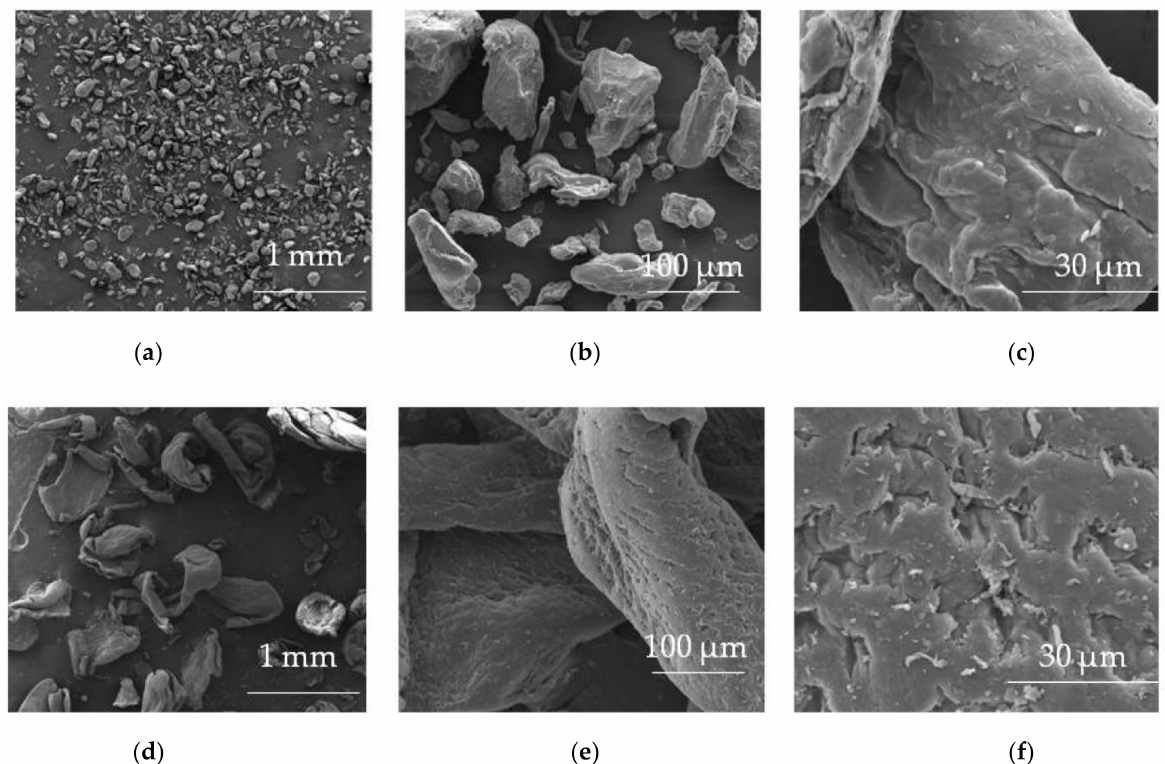
Figure 8. SEM picture of sodium alginate under magnification ( a ) 100 × , ( b ) 1000 × , and ( c ) 5000 × and chitosan particles under magnification ( d ) 100 × , ( e ) 1000 × , and ( f ) 5000 × (photographs of the authors made with Inspect™S50, FEI Company, Hillsboro, OR,